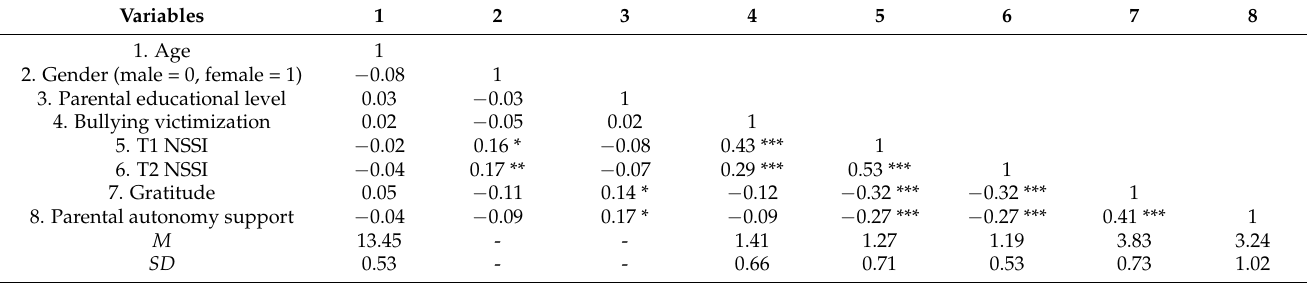
Table 1. Means, standard deviations, and correlations among study